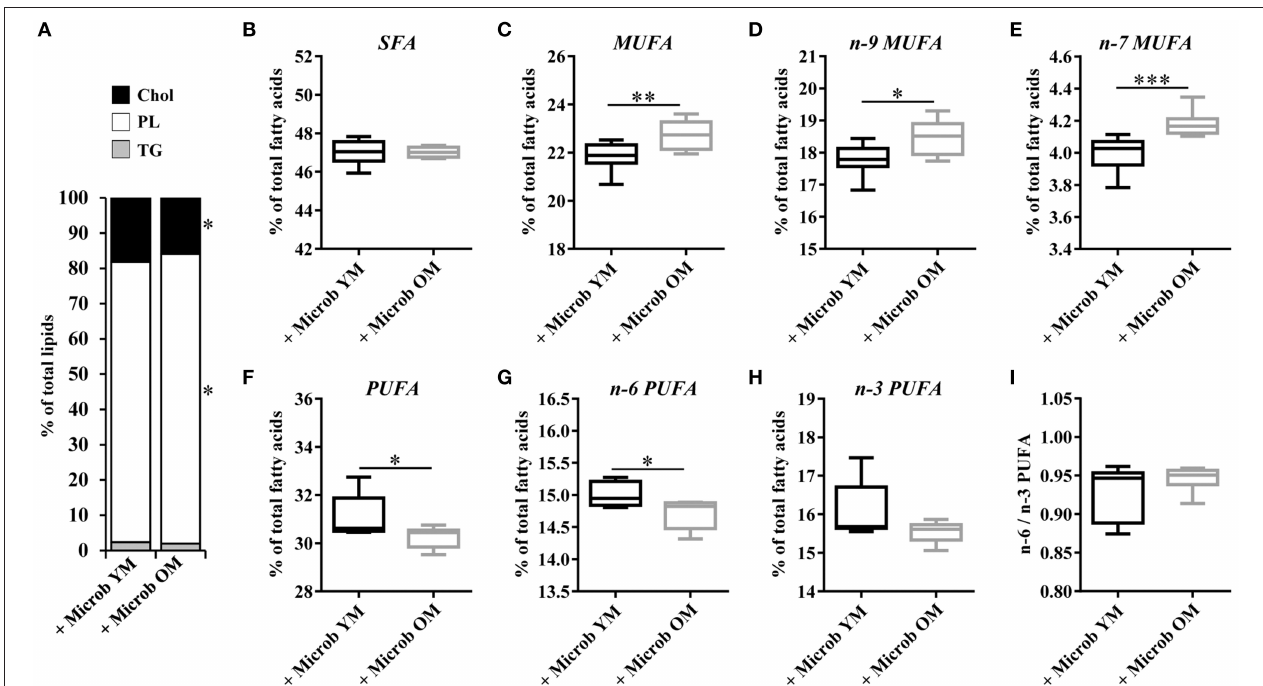
FIGURE 2 | Relative abundance of lipid classes and ester-linked fatty acids in the cortex of mice harboring different age-related microbiota. Lipids were extracted from the cortex of mice inoculated with fecal microbiota of young mice ( + Microb YM) or old mice ( + Microb OM). (A) Relative abundance of lipid classes. Results are expressed as the percentages of cholesterol (Chol), phospholipids (PL), and triglycerides (TG) relative to total lipids, defined as 100%. (B–H) Relative abundance of ester-linked fatty acids. The results correspond to the quantification of fatty acid methyl esters derivatives (FAME) by GC-FID. They are expressed as the percentages of total (B) saturated fatty acids (SFA), (C) monounsaturated fatty acids (MUFA), (D) omega-9 (n-9) MUFA, (E) omega-7 (n-7) MUFA, (F) polyunsaturated fatty acids (PUFA), (G) omega-6 (n-6) PUFA and (H) omega-3 (n-3) PUFA relative to total fatty acids, defined as 100%. (I) Ratio of n-6/n-3 PUFA. (B–I) All data are presented as mean ± SEM. n = 7 for the group of mice inoculated with the microbiota of young mice and n = 8 for the group of mice inoculated with the microbiota of old mice. Comparisons were done between the two groups of mice ( + Microb YM and + Microb OM). * p < 0.05, ** p < 0.01 and *** p <